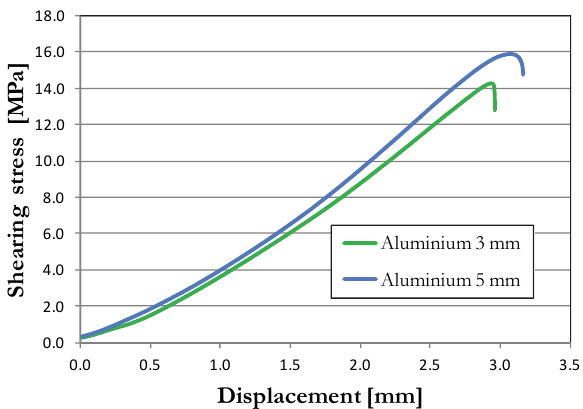
Figure 5: Influence of the aluminium adherend thickness.